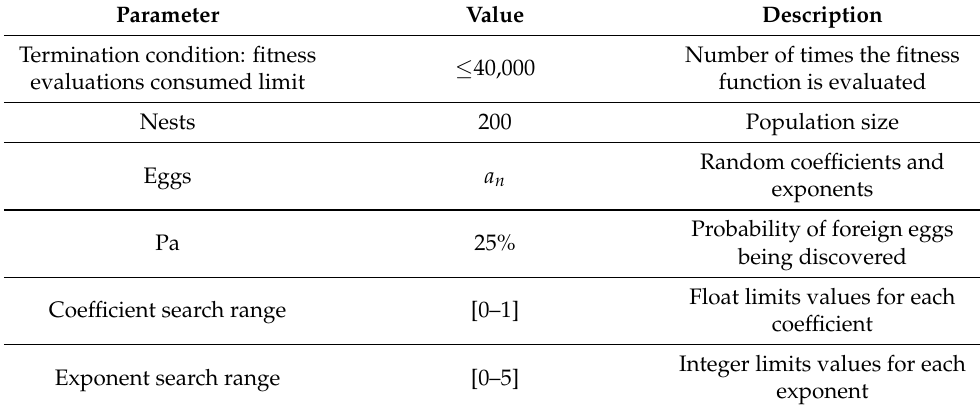
Table 3. Search parameters used for the cuckoo search